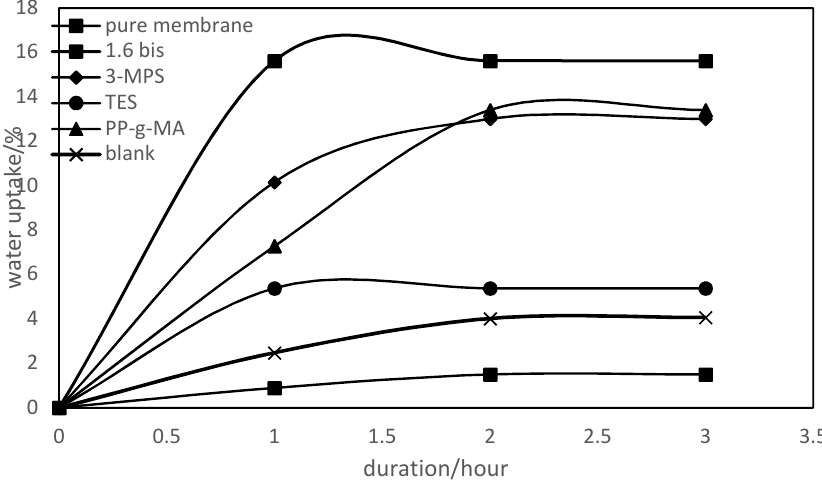
Figure 14. Effect of coupling agent on water uptake of CEMs with different GFs.